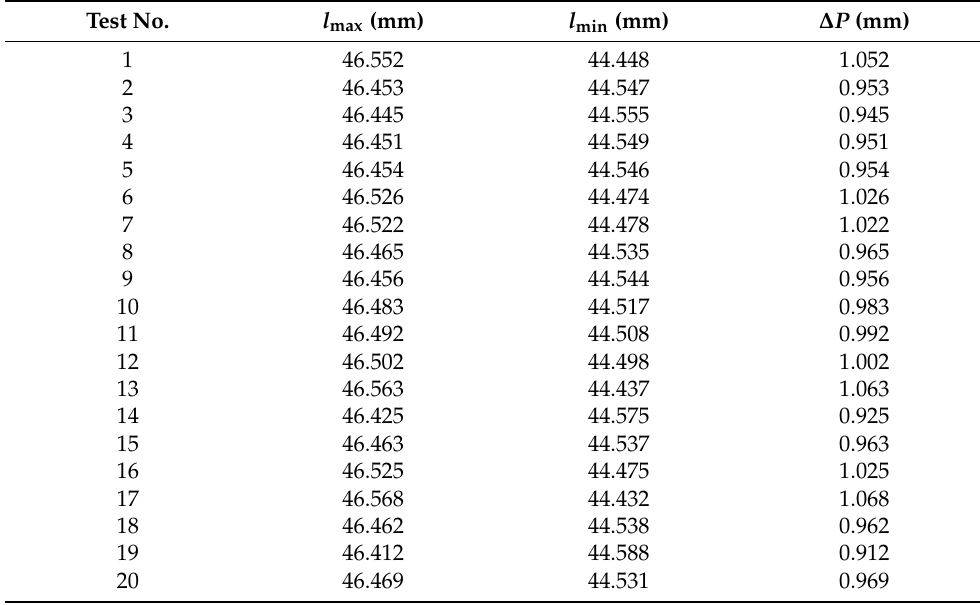
Table 3. The offset between the bolt and nut sleeve.